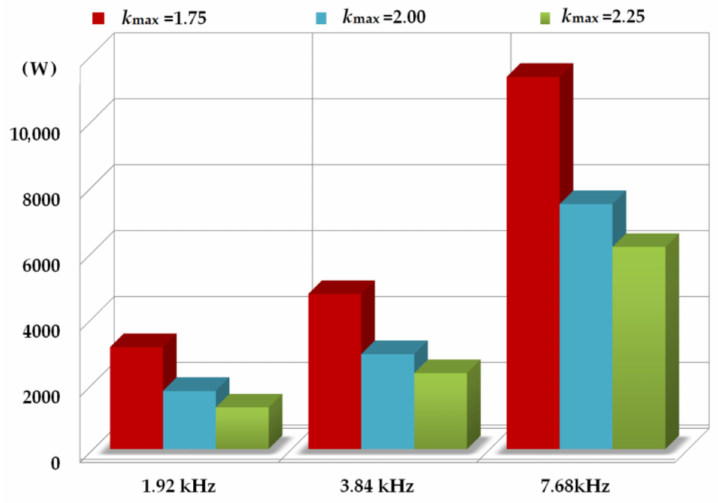
Figure 16. Total switching losses as a function of both the switching frequency and coefficient k max for the 1.2 MW inverter.